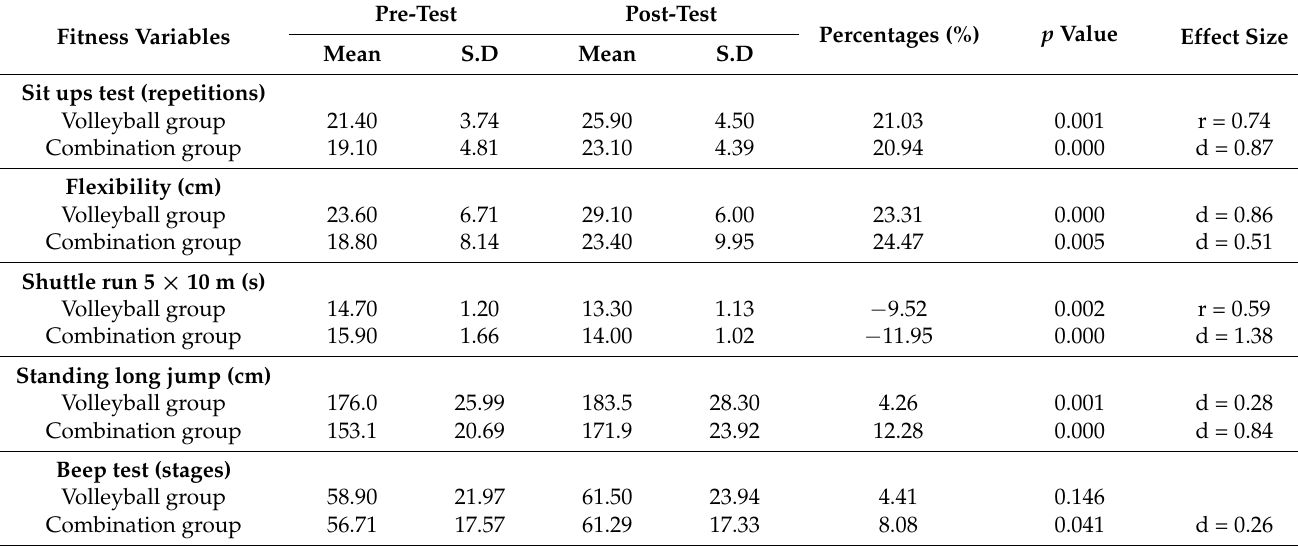
Table 2. Analysis of data for the selected fitness variables from Pre- to Post-test in Combination and Volleyball group.